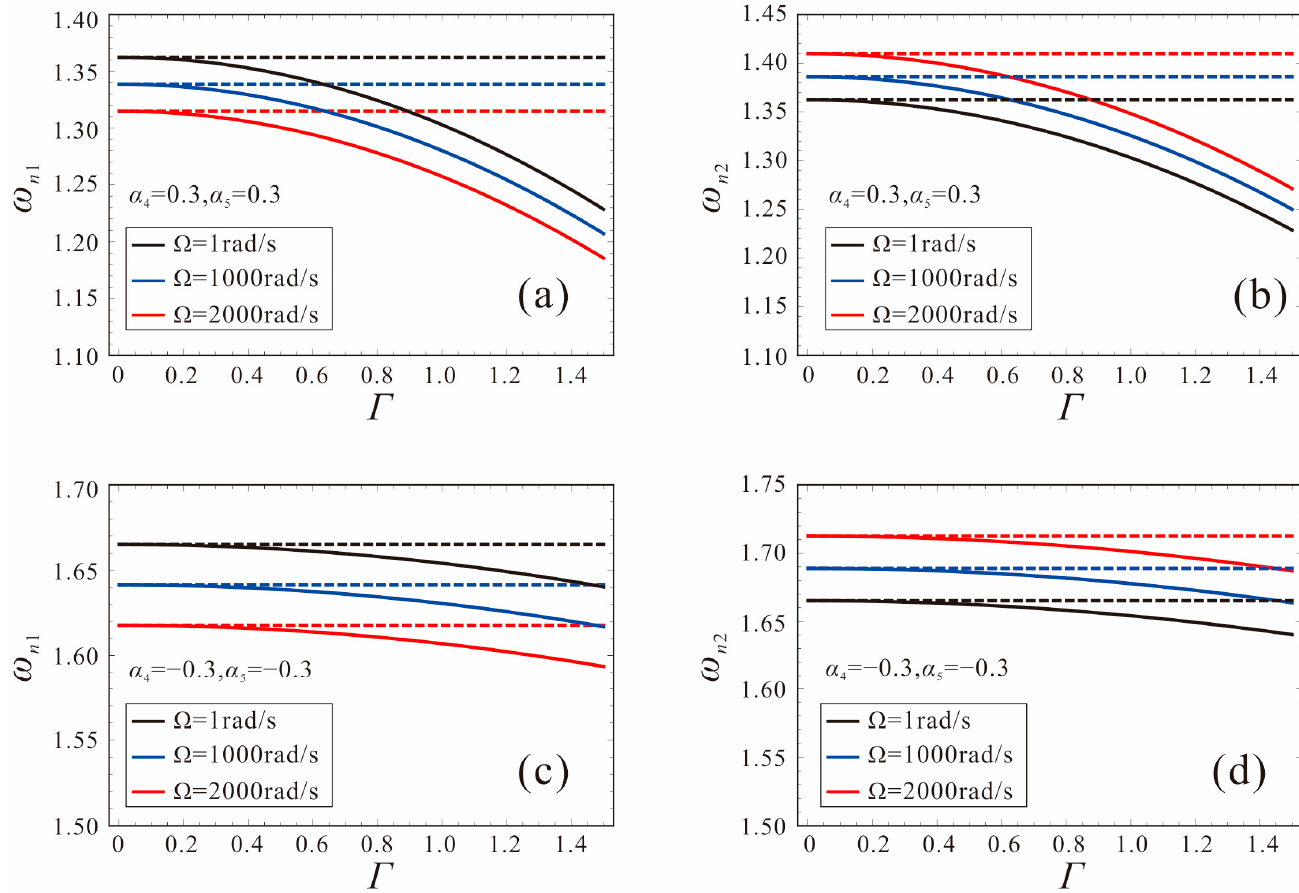
Figure 13. Variation curves of the nonlinear frequency with motion amplitude. ( a , b ): shape factors are α 4 = α 5 = 0.3; ( c , d ): shape factors are α 4 = α 5 = − 0.3.